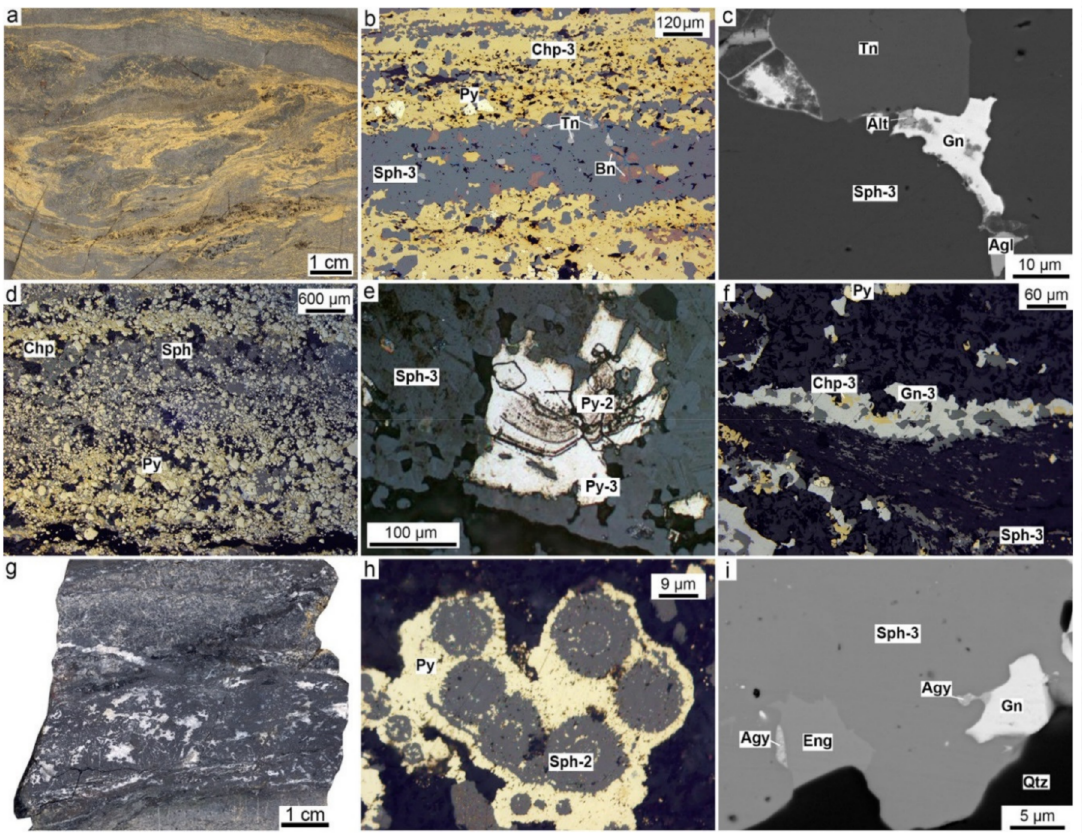
Figure 13. Mineralogical features of sphalerite-rich diagenite of the Valentorskoe ( a – c ), Aleksandrinskoe ( d – f ), and Saf’yanovskoe ( g – i ) deposits: ( a ) Intercalation of sphalerite-rich and chalcopyrite-rich diagenites with slamping texture; ( b ) a more detailed view of the previous photo; ( c ) tennantite and galena in assemblage with altaite and anglesite in sphalerite-3; ( d ) sphalerite in the upper part of the pyrite–chalcopyrite turbidite; ( e ) relict pyrite-2 clast overgrown by pyrite-3 in sphalerite-3; ( f ) lenses of galena-3, sphalerite-3, and chalcopyrite-3 in chert; ( g ) sphalerite-rich diagenites with barite (white) crowned by gray cherts; ( h ) selective replacement of colloform pyrite by sphalerite-2; ( i ) argyrodite in assemblage with galena and enargite in sphalerite-3. ( a , g ) Polished sample, ( b , d – f , h ) reflected light, ( c , i ) SEM